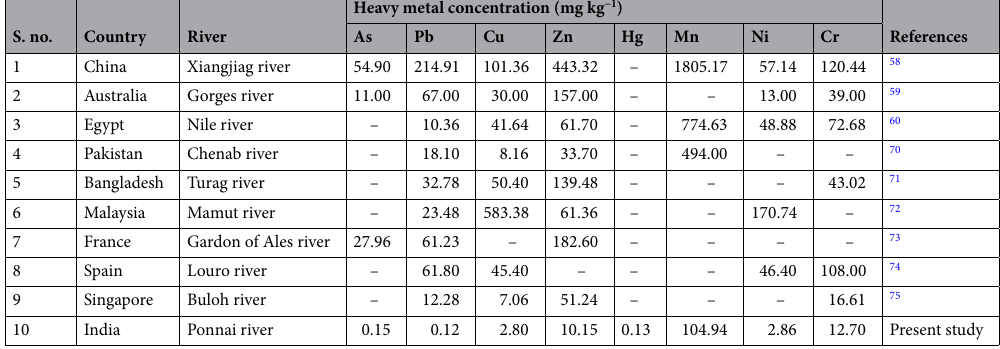
Table 6. Comparison of metal concentration in river sediments with other countries.